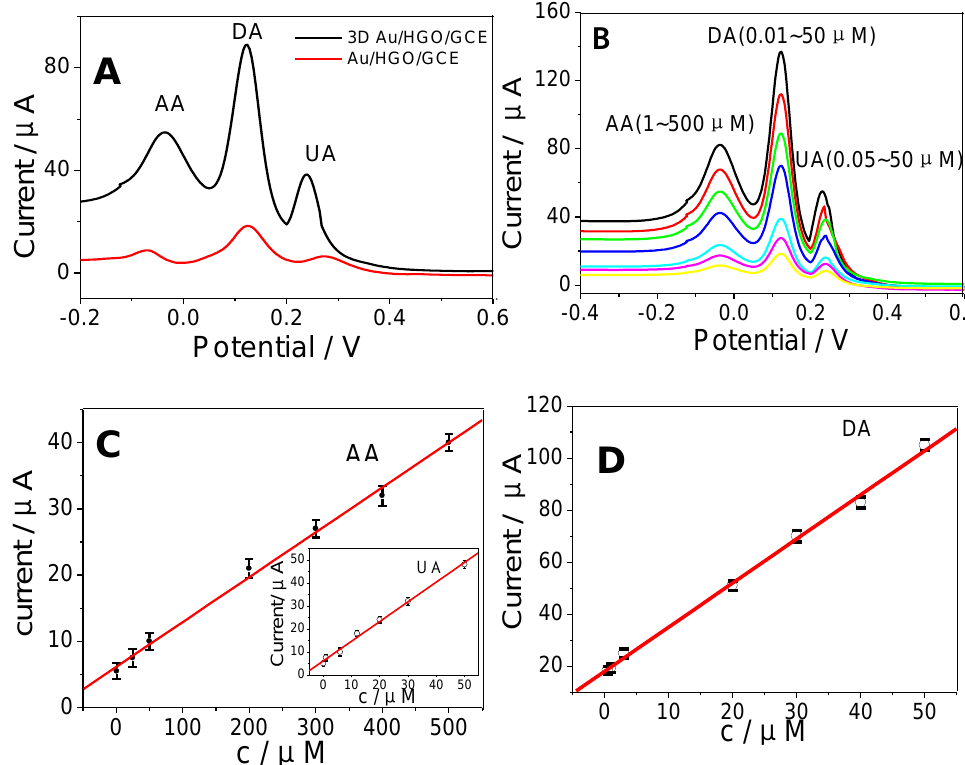
Figure 2. ( A ) Differential pulse voltammograms (DPVs) at Au/HGO/GCE and 3D Au/HGO/GCE containing 400 µ M AA, 10 µ M DA, and 15 µ M UA at a scan rate of 50 mV · s − 1 . ( B ) DPVs of 3D Au/HGO/GCE for the simultaneous determination of AA, DA, and UA in 0.1 M phosphate-buffered saline (PBS). Calibration curves of 3DAu/HGO/GCE for simultaneous determination of ( C ) AA, ( D ) DA, and UA (inset of (C)). The points on calibration curves correspond to different concentrations of AA, DA, and UA which are displayed in different colors in Figure